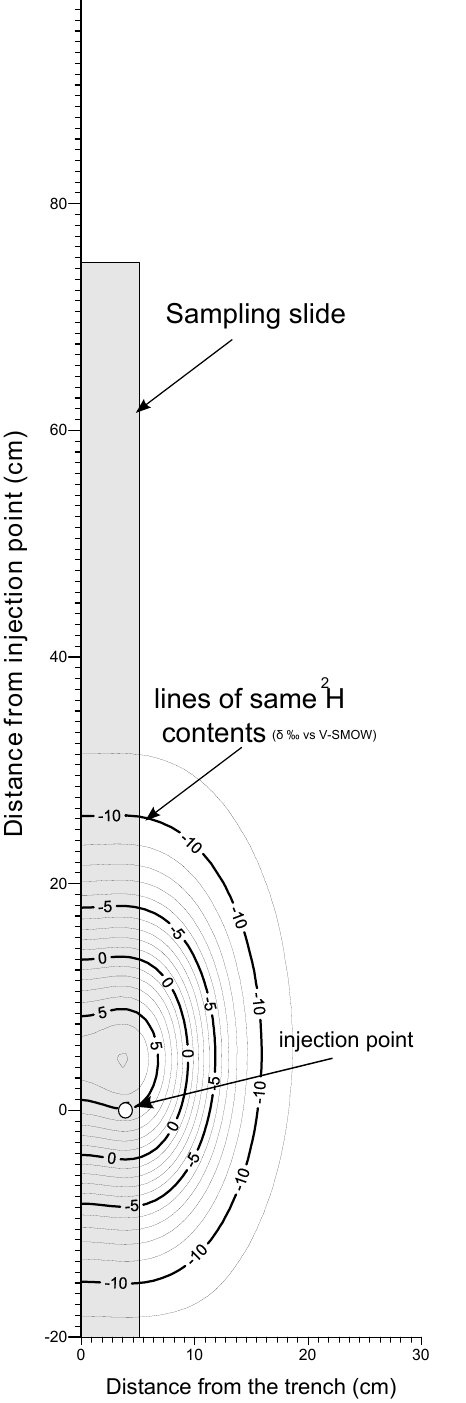
Fig. 4. Isocurves of 2 H contents ( δ ‰ vs. V-SMOW) after 35 days of tracer displacement simulated with Hydrus 2D. 2 r =0.0304, 2 s , =0.287, α =0.0304cm − 1 , K s =0.22cm min − 1 , n =2.207. Longi- tudinal dispersivity=8.15cm, Lateral dispersivity=2.24cm assum- ing a water regime at steady state between injection and recovering.